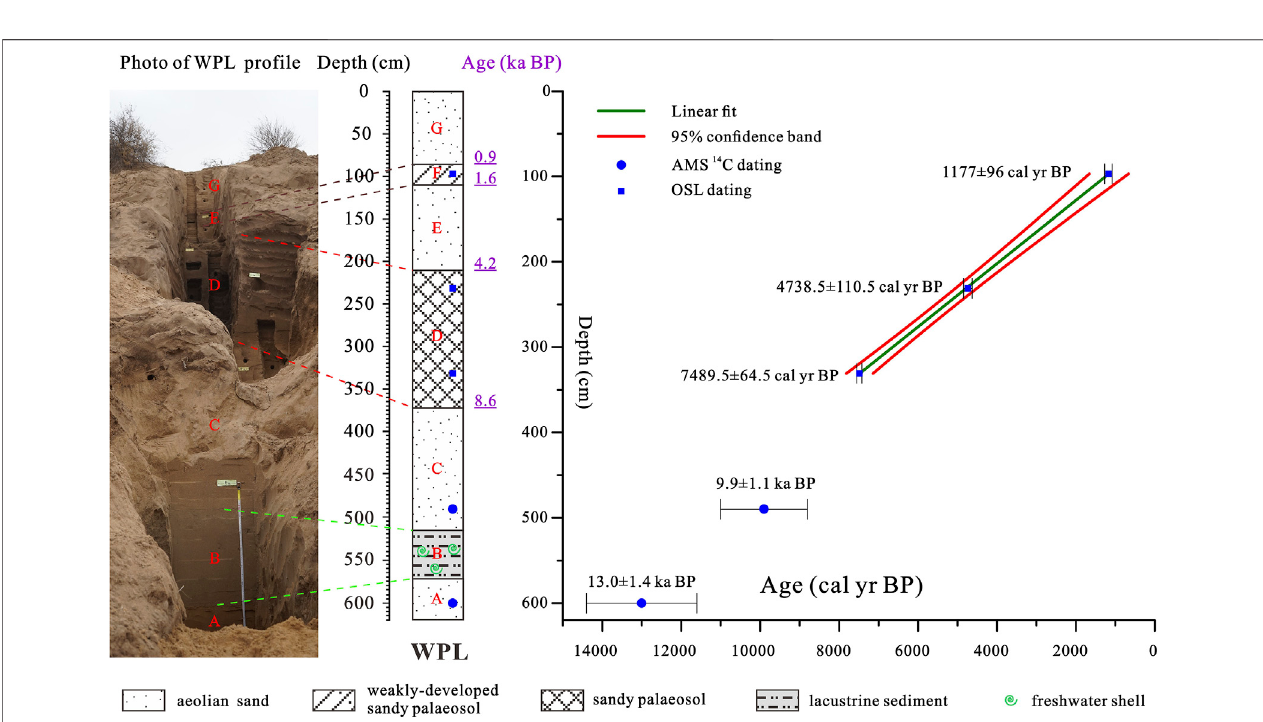
FIGURE 2 | The age-depth model for the WPL pro fi le, based on AMS 14 C and OSL ages. 2 σ calibrated age or error ranges were shown for each age and the red lines are the 95% con fi dence interval.